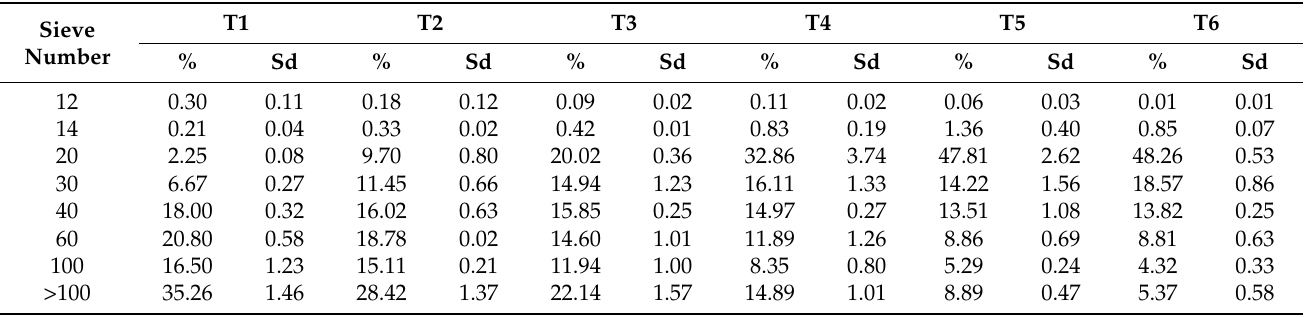
Table 1. Particle-size distribution of the raw material in Agave durangensis fibers and Pine spp. sawdust mixtures (Sd = standard